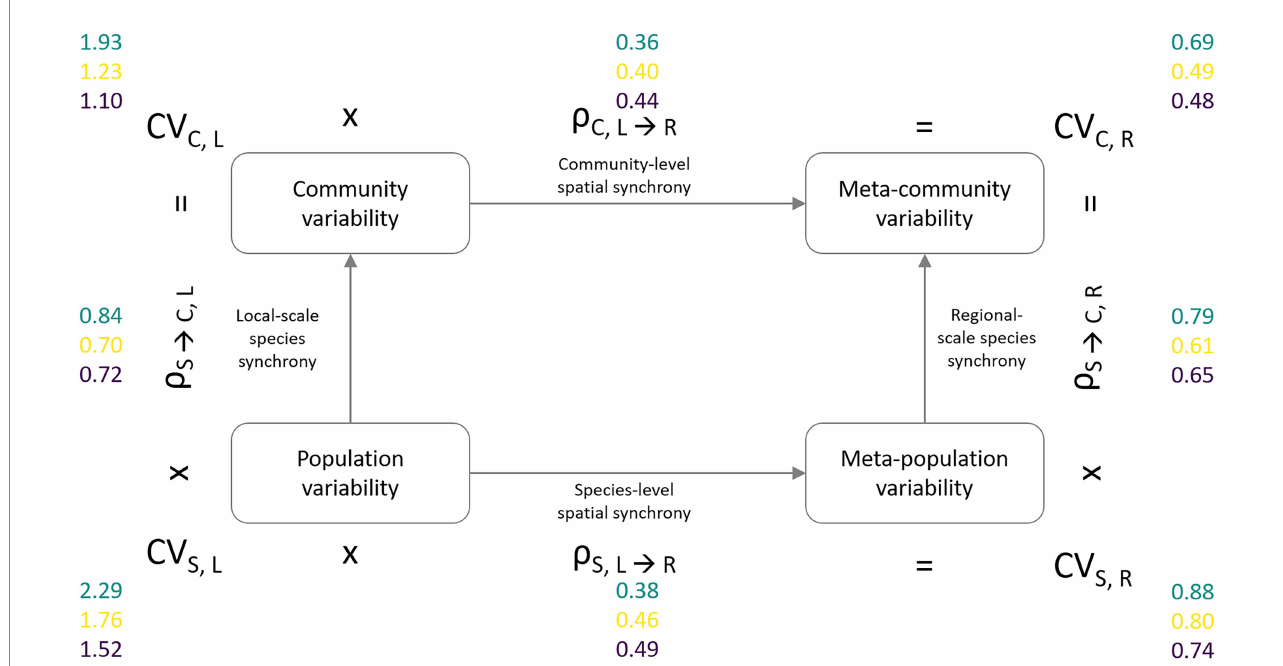
FIGURE 3 Partitioning framework of meta-community temporal biomass variability (coefficient of variation, CV) into lower levels of spatial scale (local, regional) and ecological organization (species, community). The lowest level of aggregation is represented by average species population variability (CV S,L , bottom-left corner). The intermediate level of ecological organization is the average community variability (CV C,L , top-left corner). Spatial aggregation of population variability results in spatially averaged meta-population variability (CV S,R , bottom-right corner). Meta-community variability (CV C,R , top-right corner) represents the temporal variability of the total community biomass across the sampling region. The degree of spatial, respectively, species synchrony determines the reduction in temporal variability at the next higher level of spatial and ecological aggregation (e.g., CV S,L × ρ S synchrony values are presented for the phytoplankton (green), zooplankton (yellow), and macrozoobenthos (purple) monitoring data